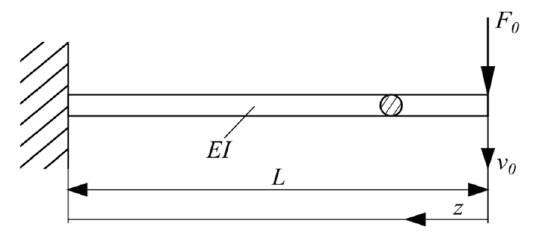
Figure A1. Schematic of round single clamped cantilever beam with a constant diameter D (small cross-sectional dimensions D / L (cid:28) 1 ) and a homogenous material